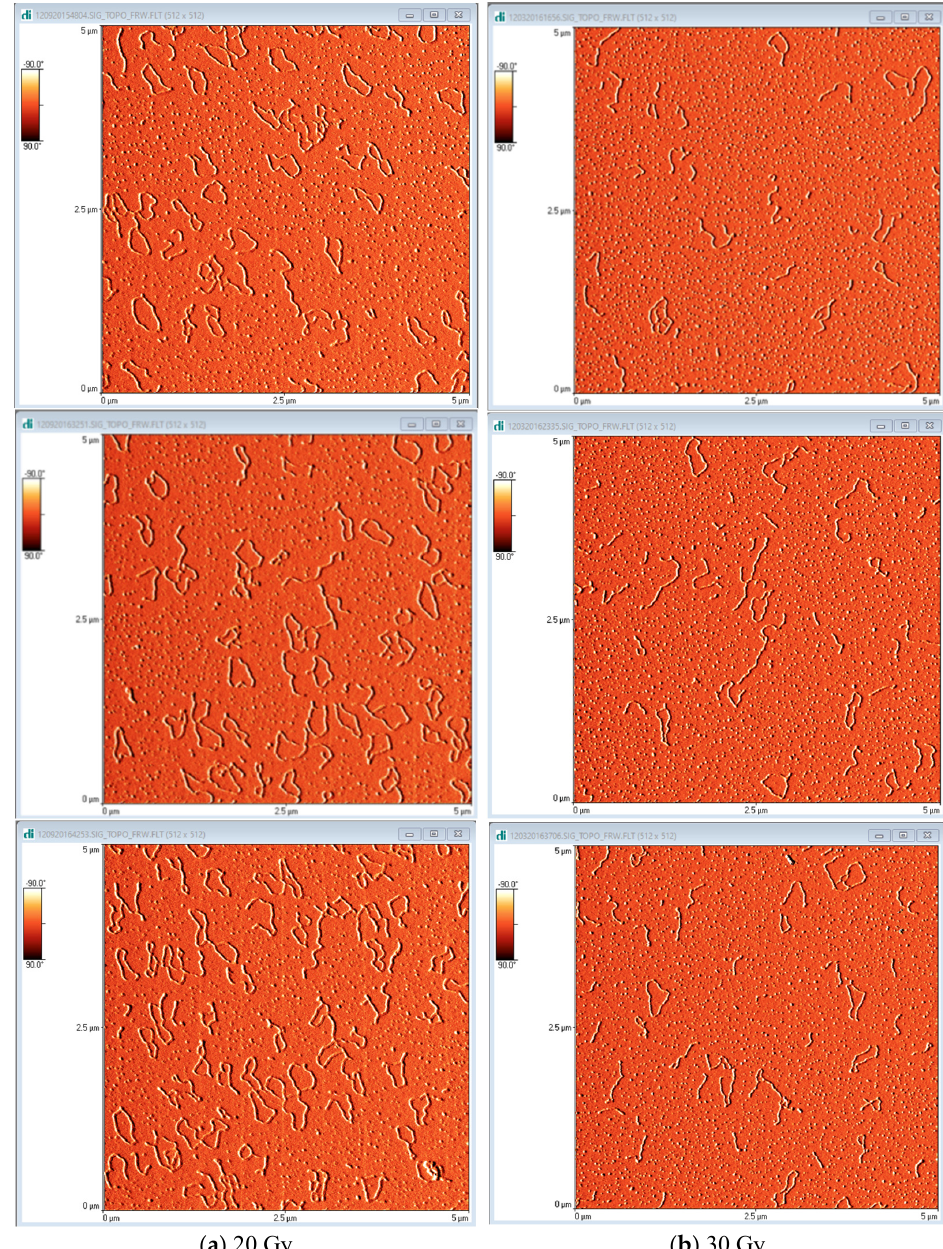
Figure A1. AFM topographic images of plasmid pBR322 on mica substrate irradiated with protons: ( a ) 20 Gy and ( b ) 30 Gy. AFM reveals the different conformations of DNA from simple linear to complex twisted loops. The difference in plasmid concentration between the two doses is incidental.